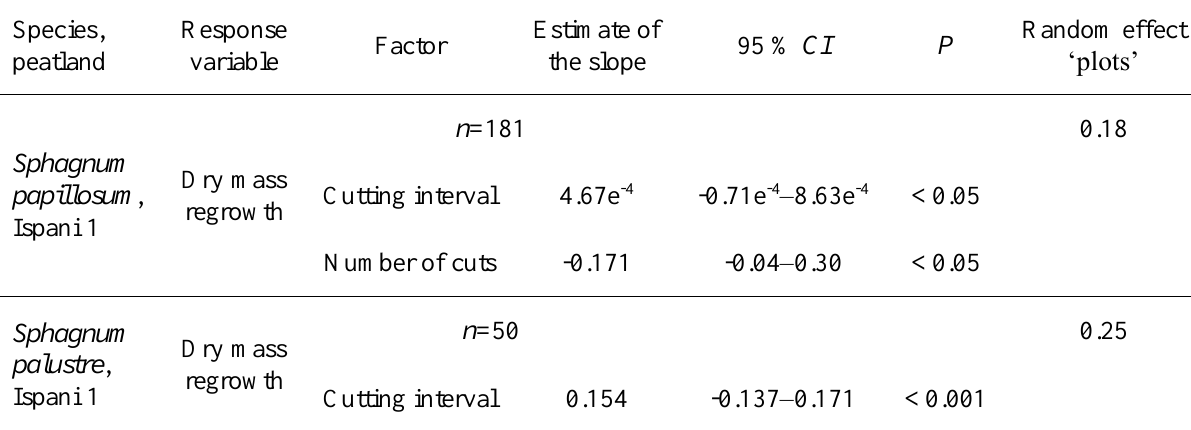
Table A1. Results of boosted generalised linear mixed modelling of the response variable dry mass regrowth of Sphagnum papillosum and S. palustre at Ispani 1, tested for the treatments initial cutting depth, cutting interval and number of cuts. CI = confidence